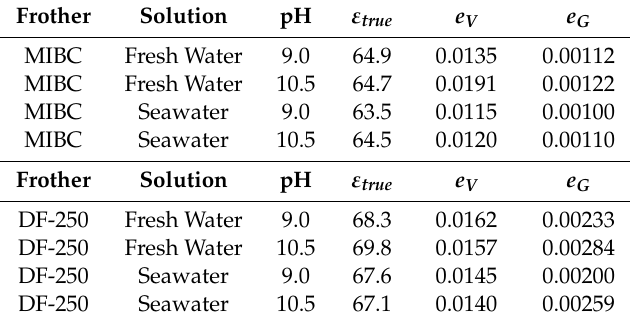
Figure3. Recoveryofvaluable / gangueparticles( ε V / ε G )vs. cumulativewaterrecovered( ε W )usingMIBC. Figure 3. Recovery of valuable/gangue particles (  V /  G ) vs. cumulative water recovered (  W ) using MIBC. Table 1. Constants of the Warren’s model ( Method 2 ). MIBC, methyl isobutyl